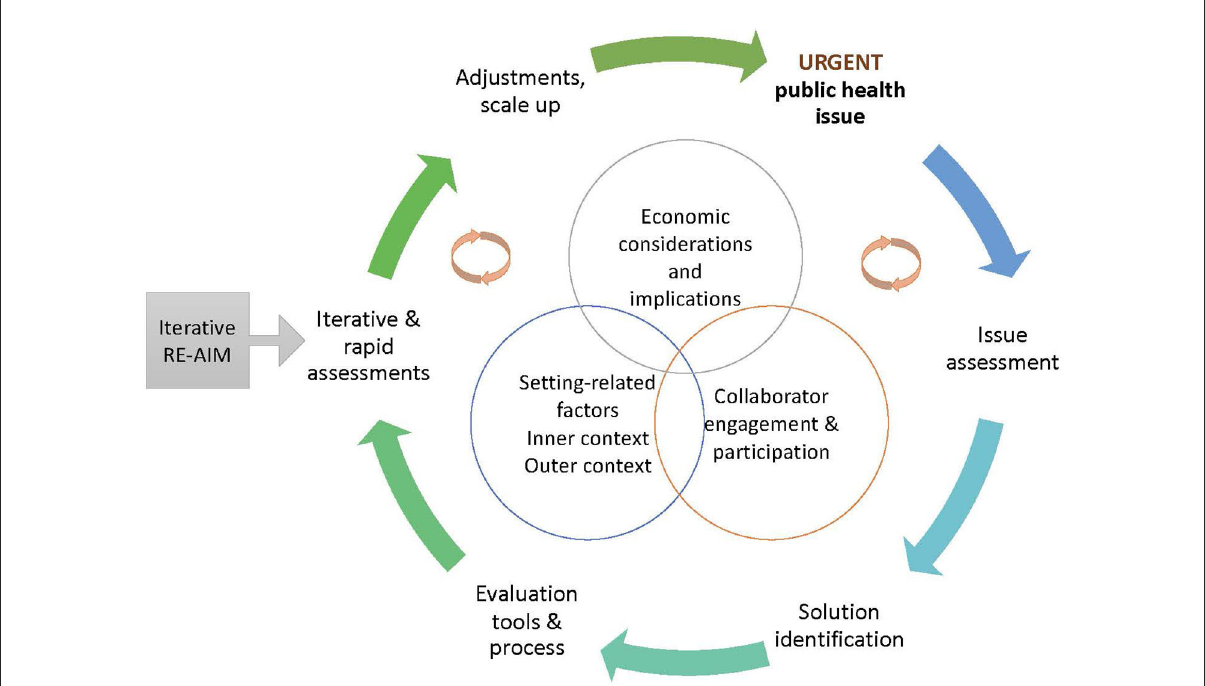
FIGURE1 Common steps across the rapid adaptation process: collaborator engagement, setting-related factors, and economic implications are central as are the cyclical, rapid, iterative nature of the processes.